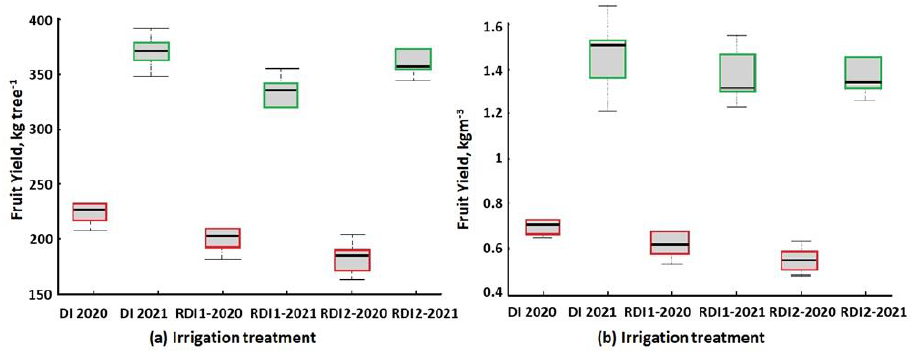
Figure 18. Fruit yield ( a ) per tree, and ( b ) per cubic meter during both seasons and irrigation treatments. Green squares refer to 2021 pruned trees; red squares refer to 2020 trees.